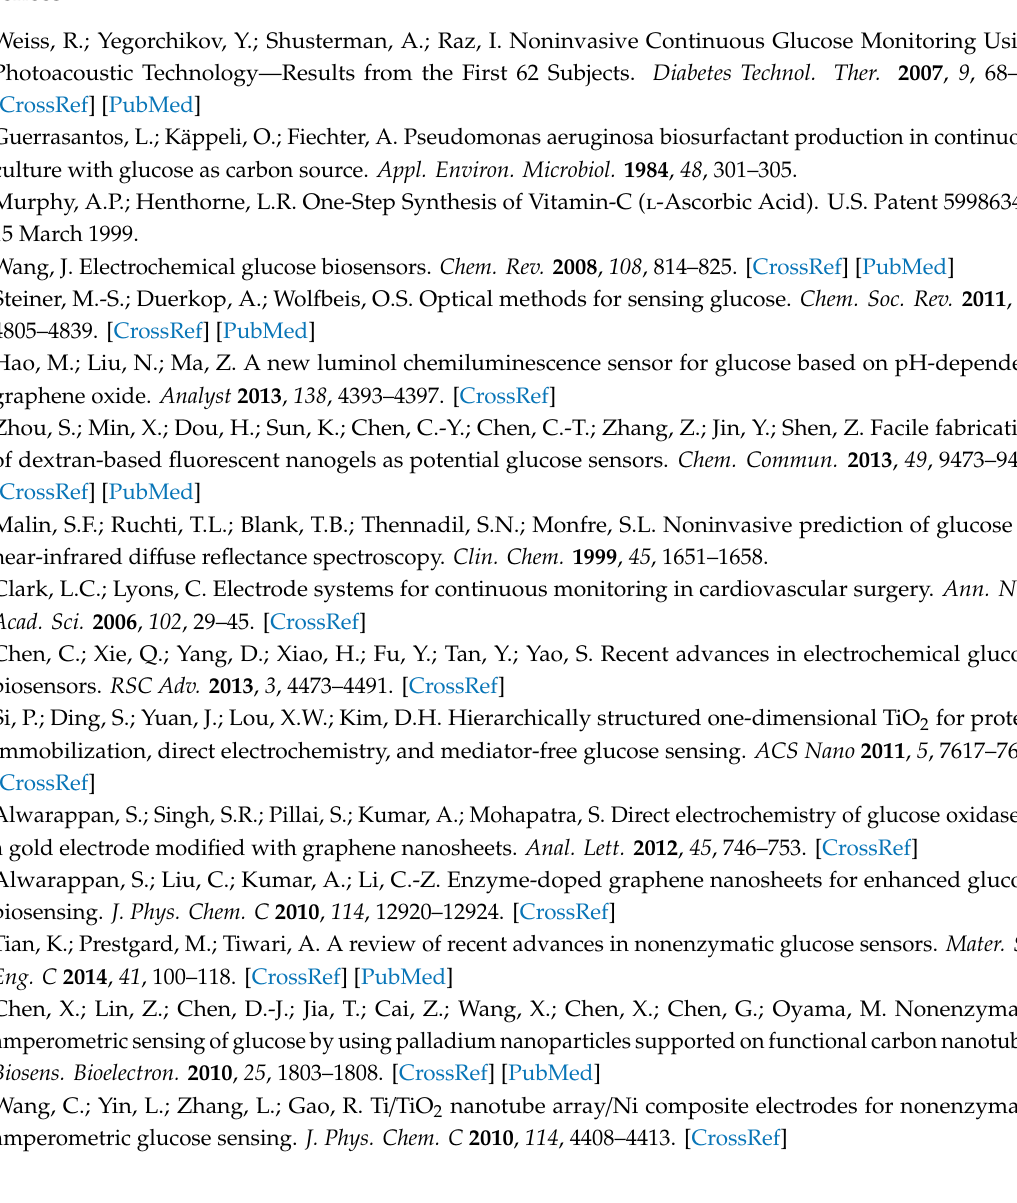
Figure S1: Comparison of di ff erent glucose sensors’ performance, Figure S2: The SEM images of 5M-0.1-300, 5M-0.1-1200, 3M-0.1-300, 5M-0.1-1200, Figure S3: The Raman spectrum of the Cu 2 O electrodes fabricated under di ff erent